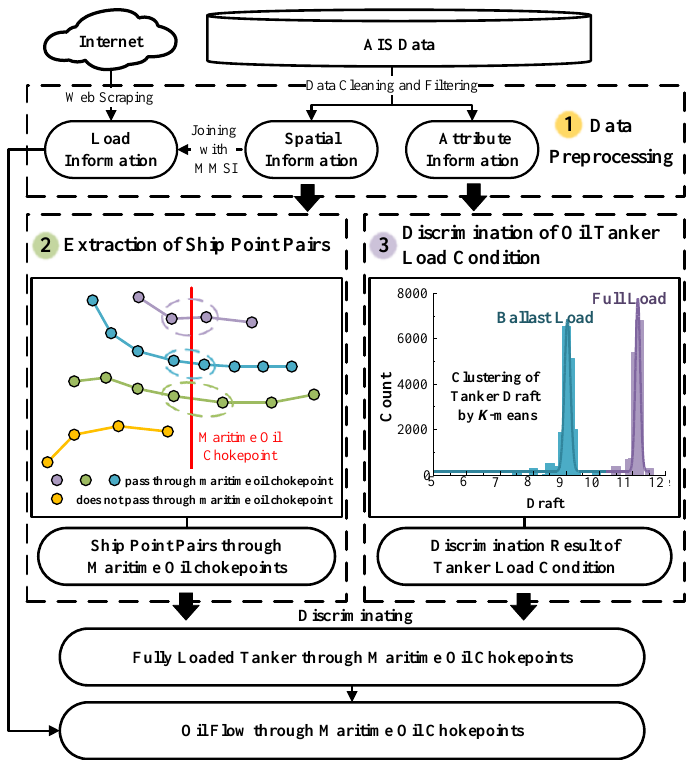
Figure 2. Main technical framework.